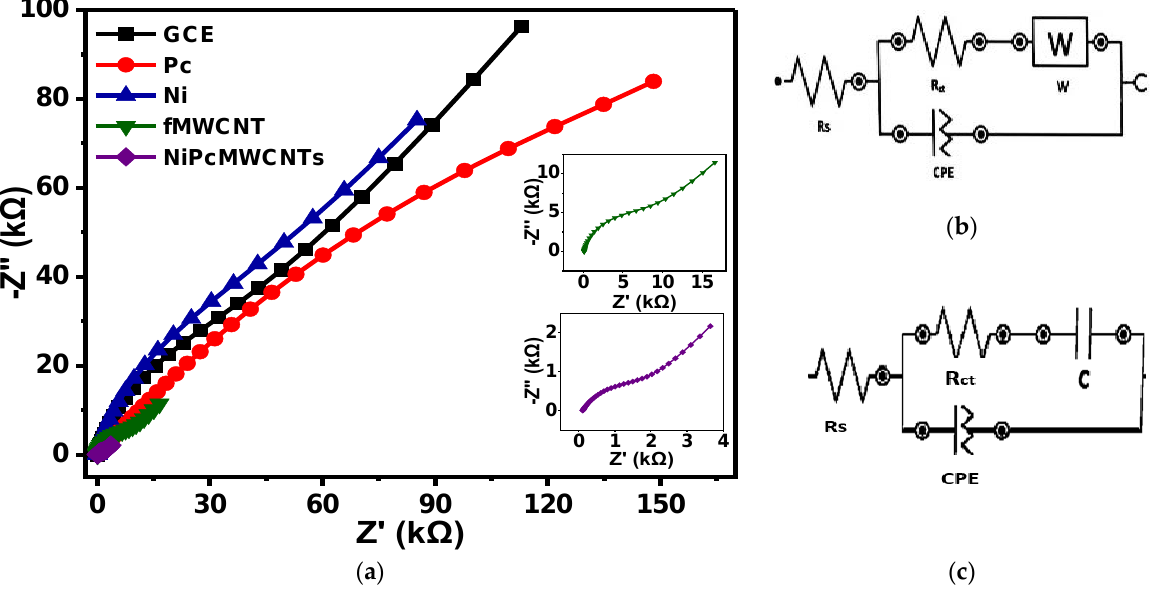
Figure 10. ( a ) Nyquist plots of GCE and modified electrodes in 0.1 M KBrO 3 solution produced in 0.1 M PBS (pH 7.0). ( b , c ) The circuit used for fitting the EIS data ( b ) for GCE, Ni, fMWCNTs, and NiPcMWCNTs and ( c ) for Pc).